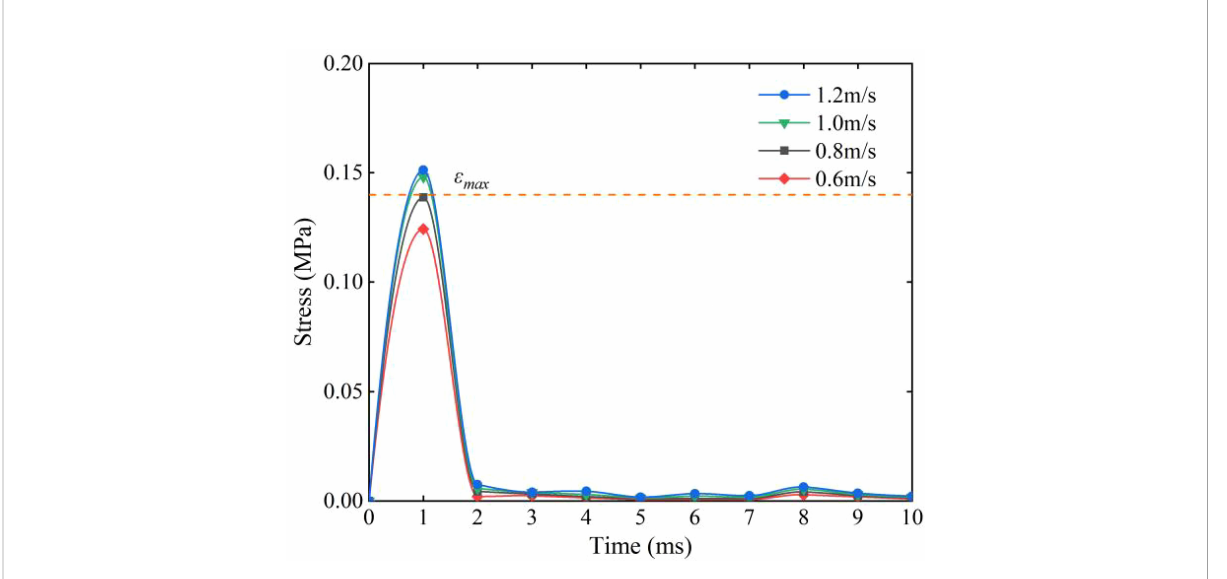
FIGURE 13 Response curves of deep-sea organisms at different collision